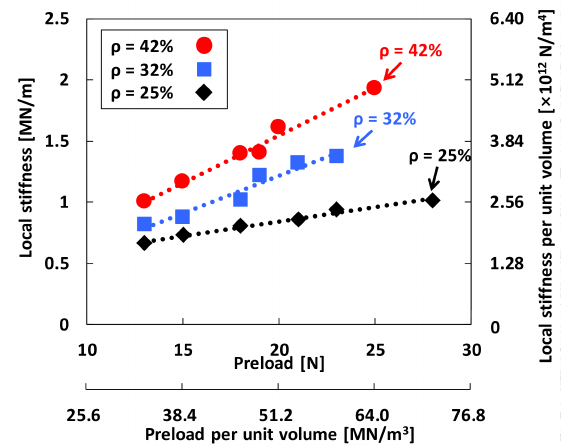
Figure 9. Local hysteresis loop measurements: Local stiffness K Local (left vertical axis) and local stiffness K Local per unit volume (right vertical axis) versus preload F Pre (upper horizontal axis) and versus preload F Pre per unit volume of WMD (lower horizontal axis). The circle, square, and diamond symbols denote the local stiffnesses of the WMDs with 42%, 32%, and 25% densities, respectively.